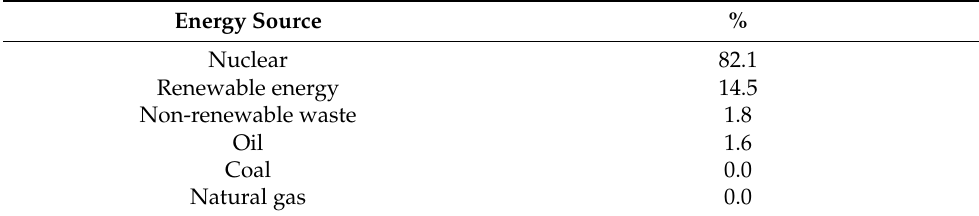
Table 7. Energy production by source (%), 2017. Source: ICAEN.